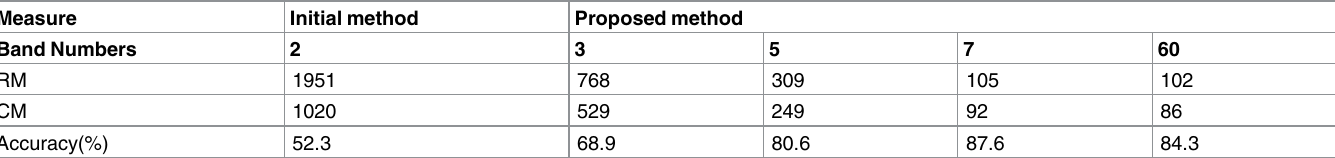
Table 1. Comparison between the initial method and proposed